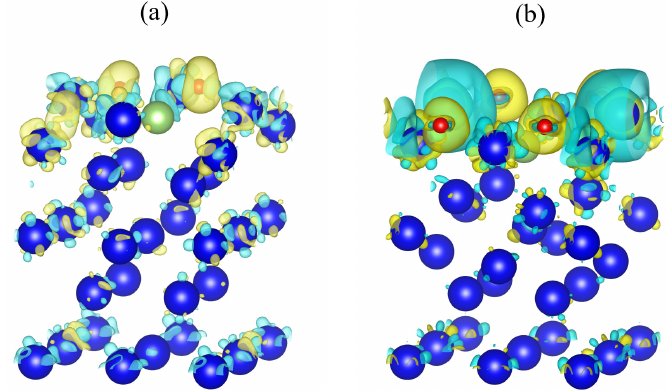
Figure 4. Differential charge density: ( a ) O-b-hor2 ( b ) O-h-ver. (Note: the electron density equivalent surface is 7.0 e/nm 3 , yellow indicates an increase in charge density, blue indicates a decrease in charge density).